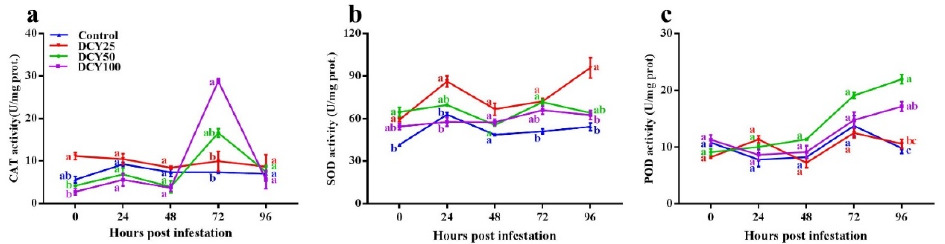
Figure 3. Activities of antioxidant enzymes in rice leaf sheaths in response to DCY treatment and SBPH infestation. ( a ) CAT, ( b ) SOD, ( c ) POD. Data represent means ± standard error of three replicates. Significant difference between DCY and control plants is indicated by letters (a,b,c) ( p < 0.05, Tukey’s HSD